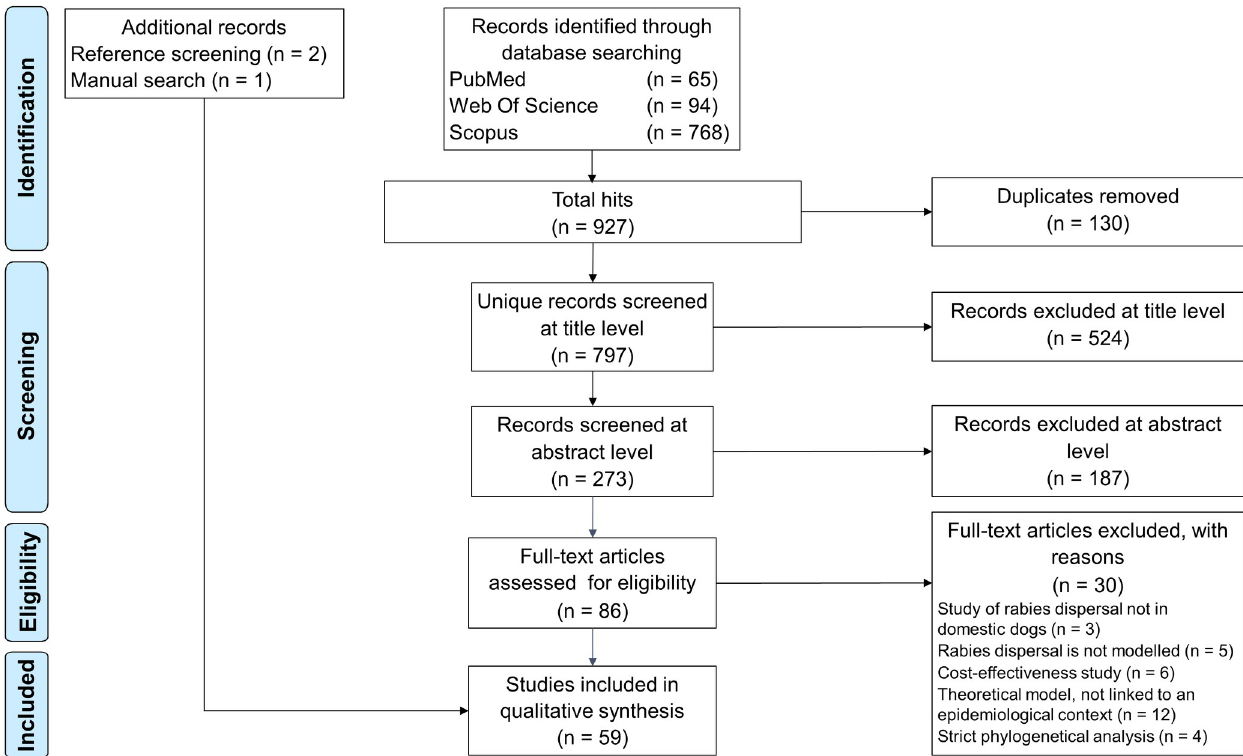
Fig 1. PRISMA-ScR Flow Diagram showing the number of identified and selected records along the multi-stage selection process. Scopus accounted for most of the records as it retrieved 71% ( n = 46) of PubMed records and 79% ( n = 74) of Web of Science records.